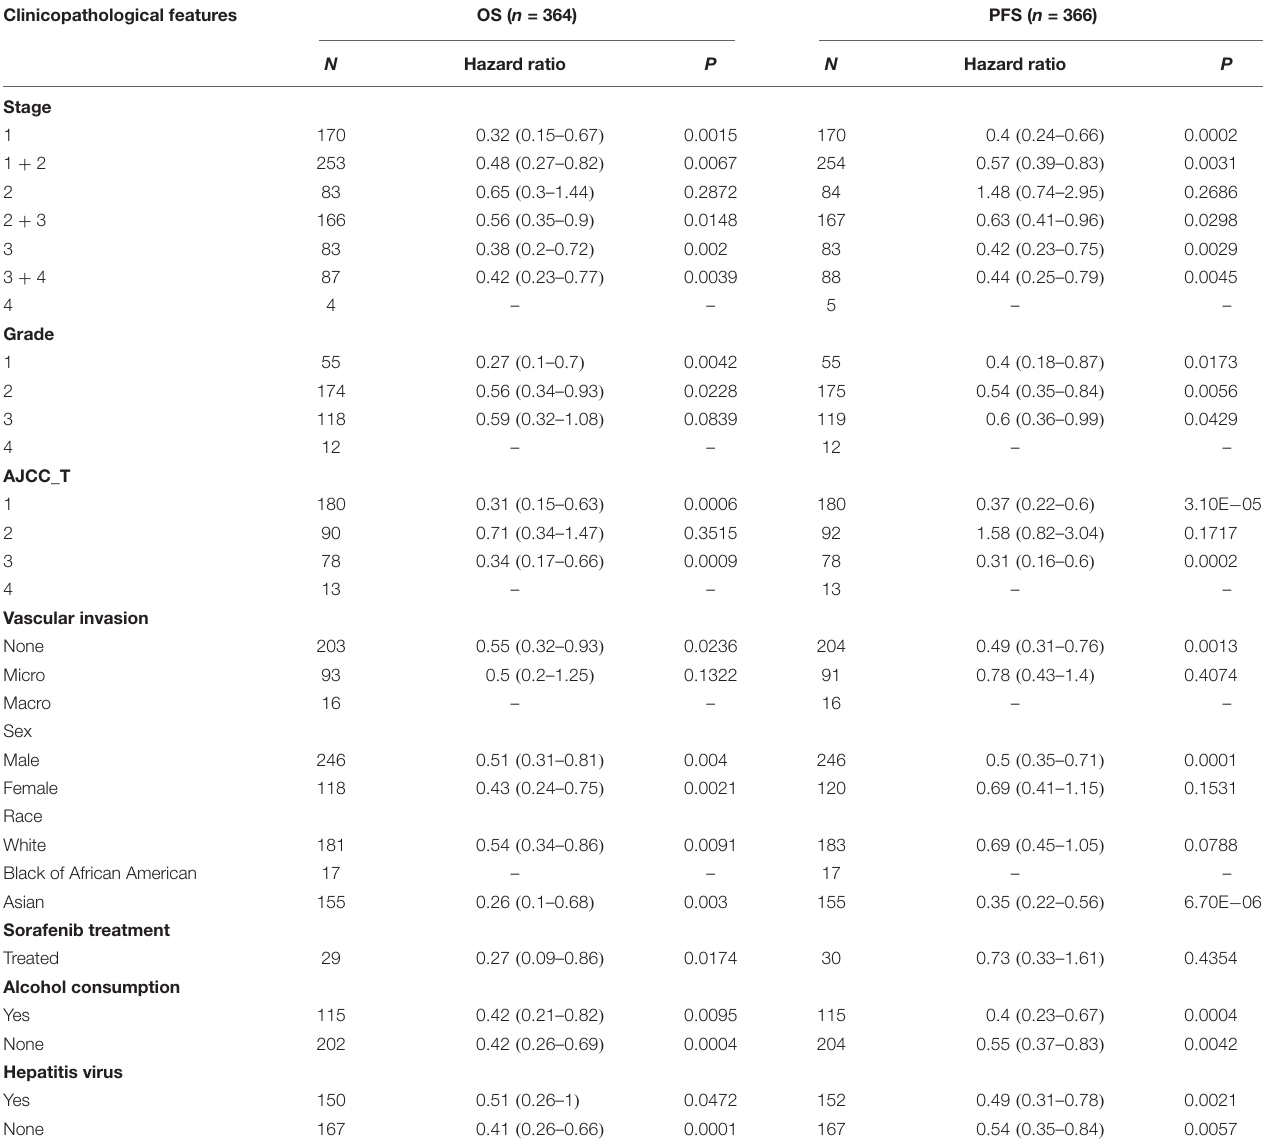
TABLE 1 | Correlation of ACE2 messenger RNA expression with OS ( n = 364) and PFS ( n = 366) in LIHC with different clinicopathological features. Clinicopathological